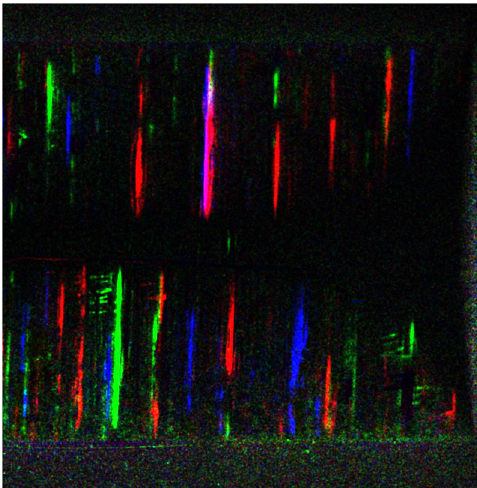
FIG. 3. Superposition of three magneto-optical differential im- ages of flux penetration in a YBCO film on a (cid:2) ¼ 14 (cid:1) -tilted substrate. The different monochrome image series are color coded in red, green, and blue, respectively. The presence of colored superpositions shows that the flux jumps are not repro- ducible. The sample temperature is T ¼ 4 K , the applied magnetic field is B a ¼ 16 : 7 mT , and the field step is (cid:1) B a ¼ 42 : 5 (cid:3) T . The scale is the same as for Fig. 2(a).